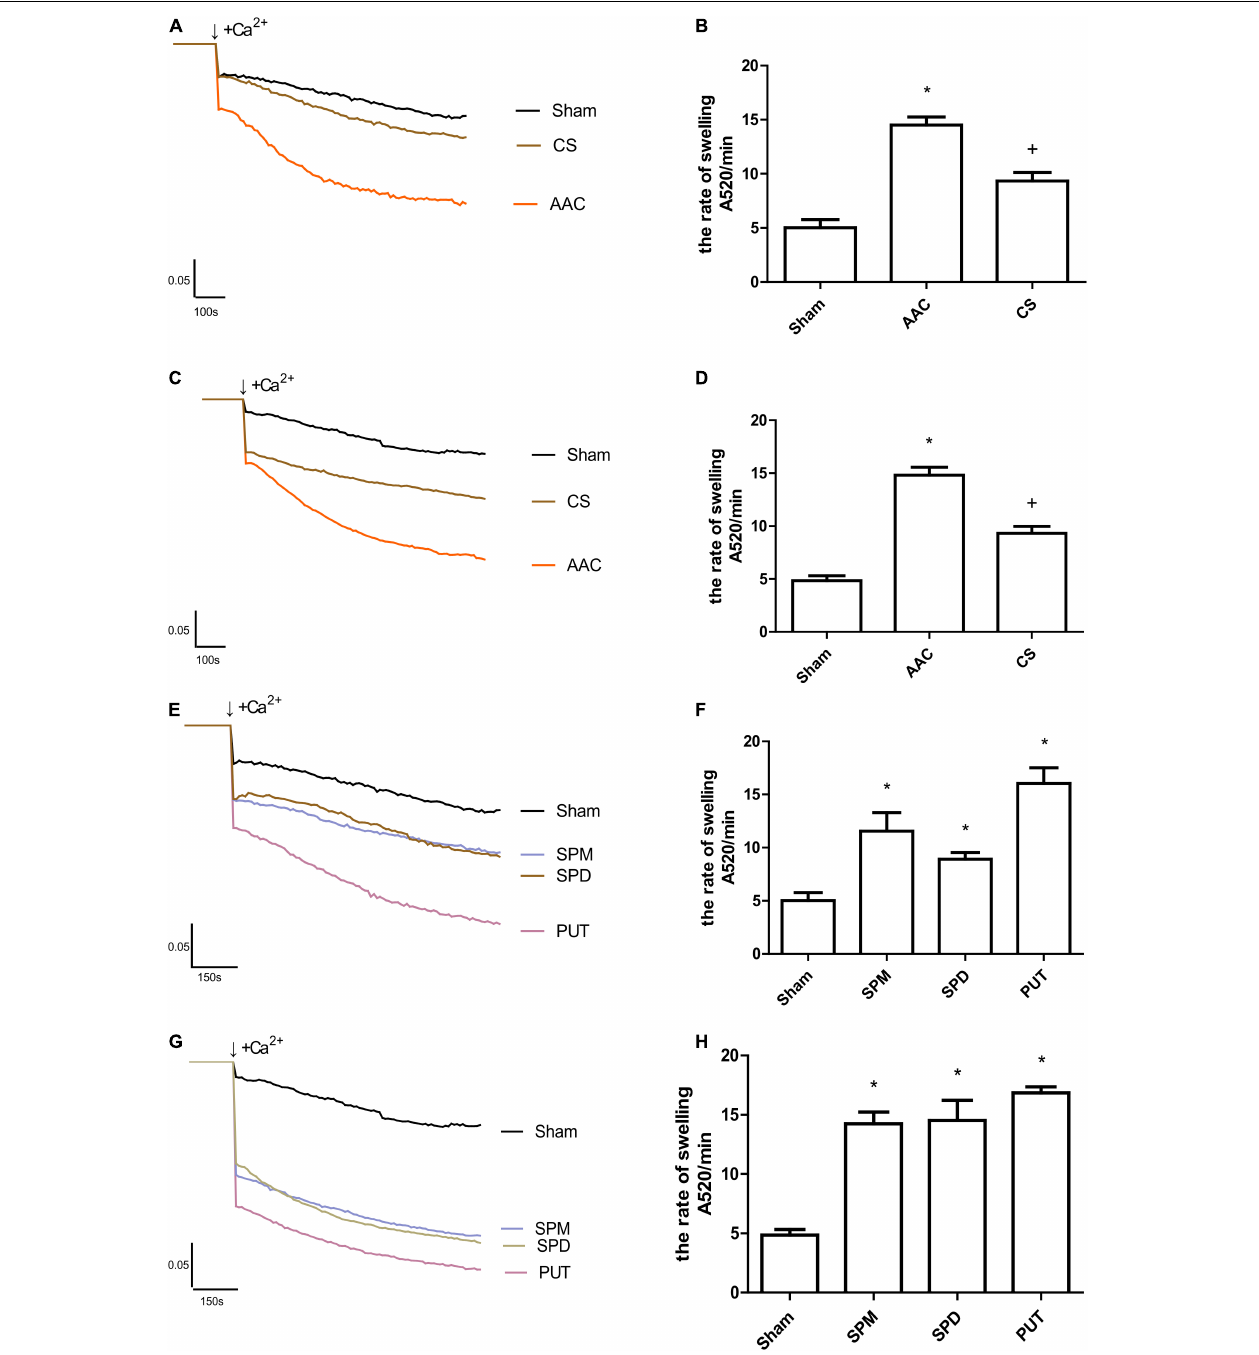
FIGURE 4 | Changes in Ca 2 + -induced mitochondrial swelling rate. (A,B) Tracings of cardiac mitochondrial swelling (A) , and statistics of swelling rates (B) 4 weeks after different treatments; (C,D) Tracings (C) and statistics (D) of cardiac mitochondrial swelling 8 weeks after different treatments; (E,F) Tracings (E) and statistics (F) of cardiac mitochondrial swelling 4 weeks after administration of polyamines; (G,H) Tracings (G) and statistics (H) of cardiac mitochondrial swelling 8 weeks after administration of polyamines. AAC, abdominal aortic constriction; CS, cromolyn sodium; PUT, putrescine; SPM, spermine; SPD, spermidine; n = 7 per group.; * P < 0.05 vs Sham group; + P < 0.05 vs AAC